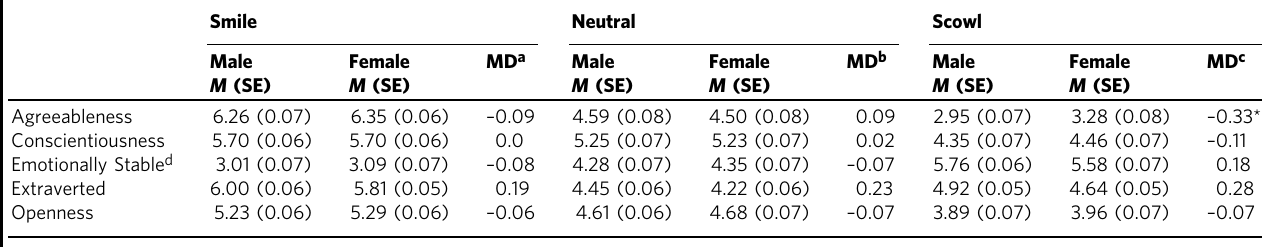
Table 7 Facial expression and gender, Big-Five personality traits ( M , SE, mean difference).